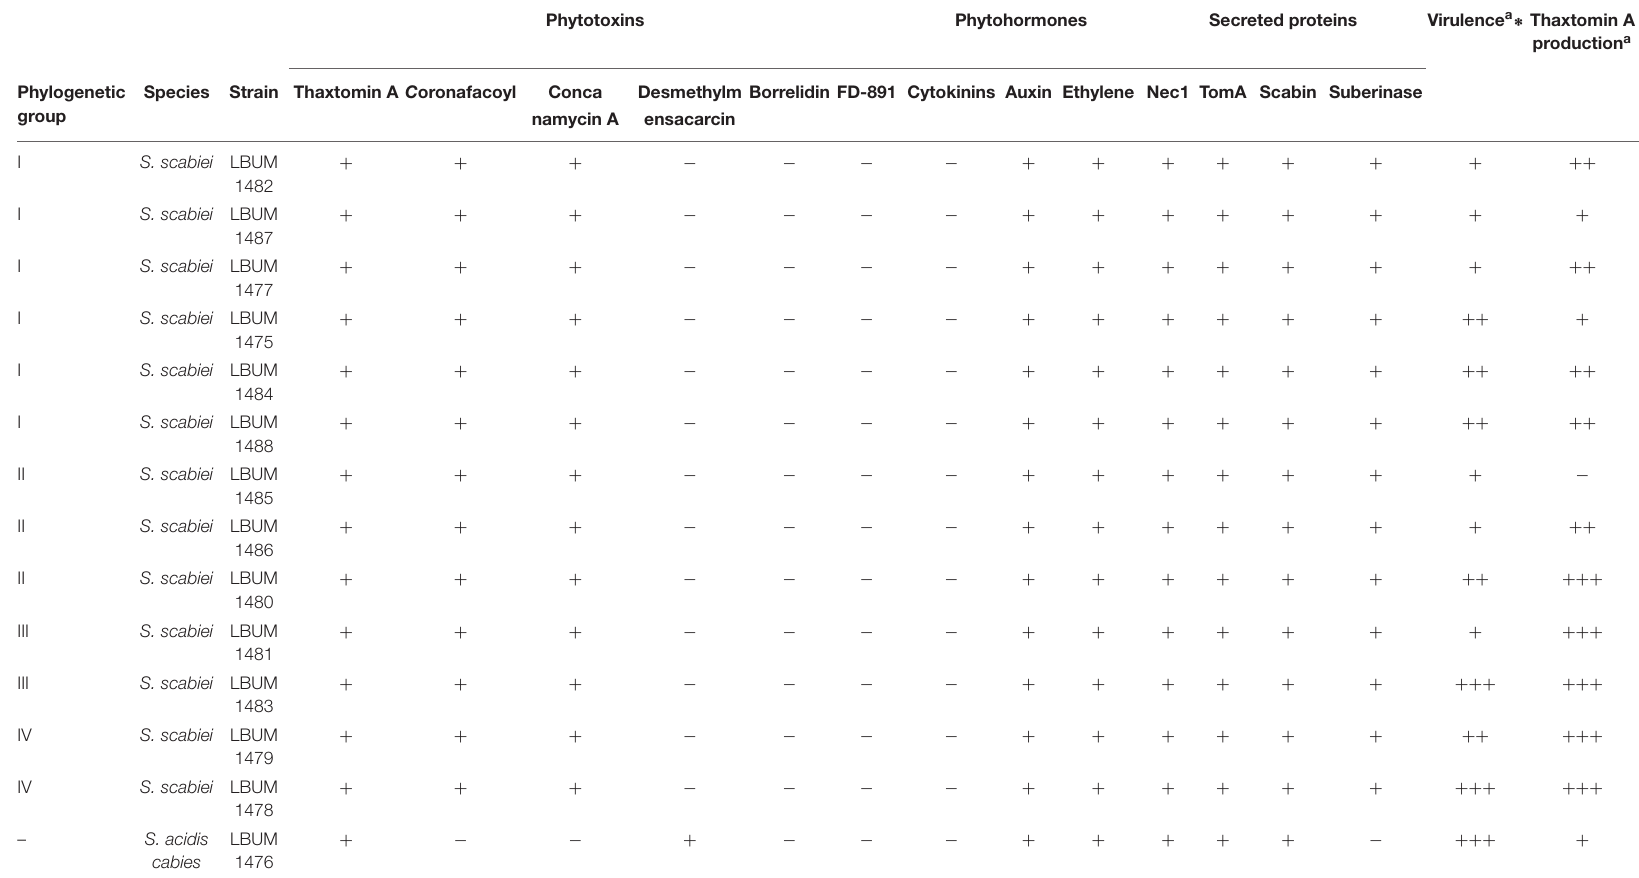
TABLE 2 | In silico analysis of the pathogenic determinants involved in pathogenicity and/or virulence of scab-causing Streptomyces spp., and their relative virulence and thaxtomin A